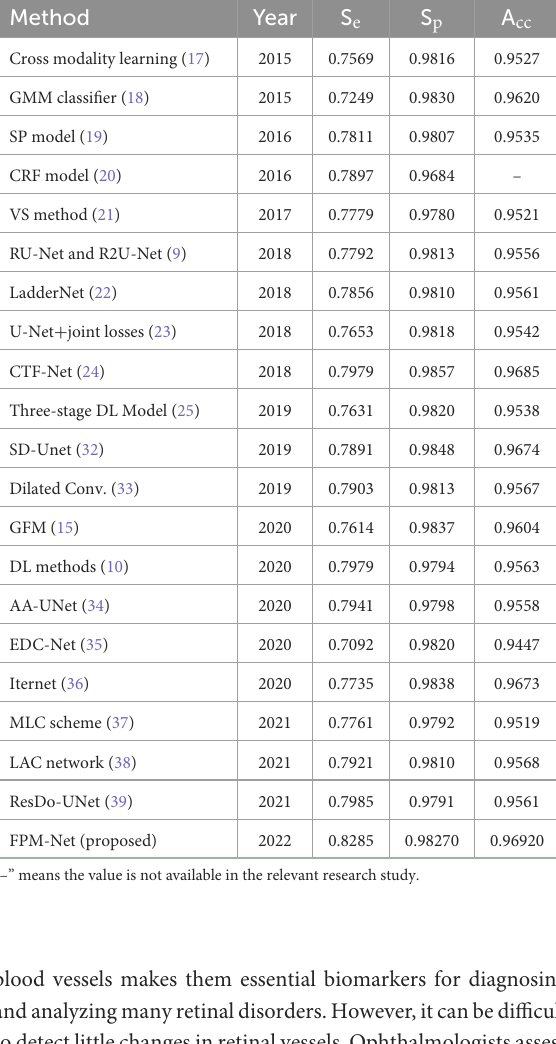
TABLE 3A The comparison of the DRIVE data set’s segmentation results using various segmentation